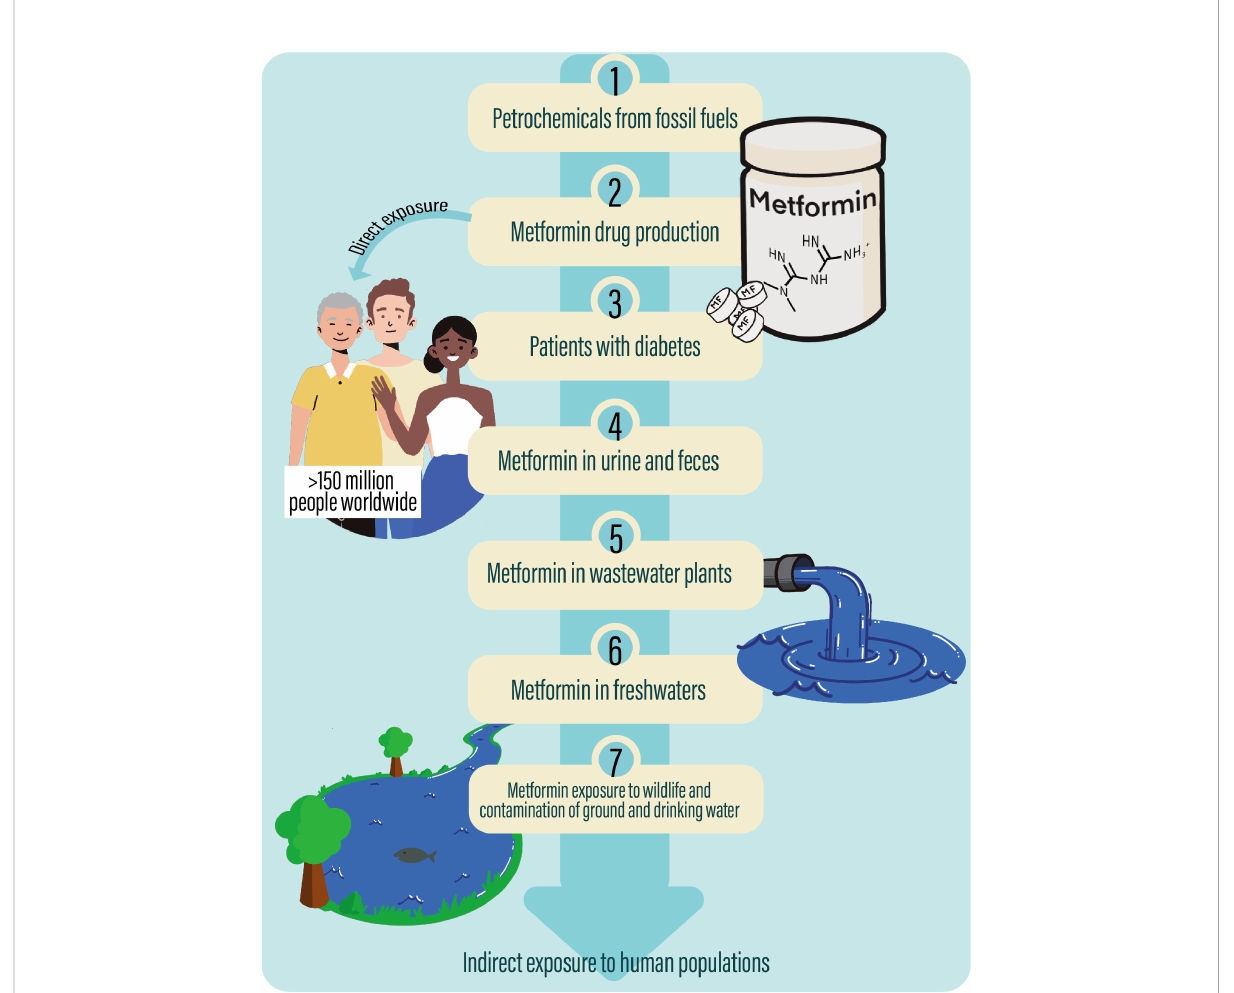
FIGURE 1 Metformin ’ s path from the synthesis of the drug from petrochemicals to contamination of the environment via wastewater. 1) Metformin derives from petrochemicals, which again derive from fossil fuels such as oil. 2) From petrochemicals there is a production of the drug, metformin which is 3) prescribed to more than 150 million people, including a large proportion of patients with diabetes 2, who thus are directly exposed through therapeutic treatment. 4) As metformin is not metabolized in the human body, it enters the environment unchanged through urine and feces, and 5) metformin thus reaches wastewater treatment plants and later 6) freshwaters as rivers and lakes and drinking water. 7) Metformin, therefore, contaminates our environment affecting the aquatic wildlife and potentially exists as indirect exposure to human populations all over the